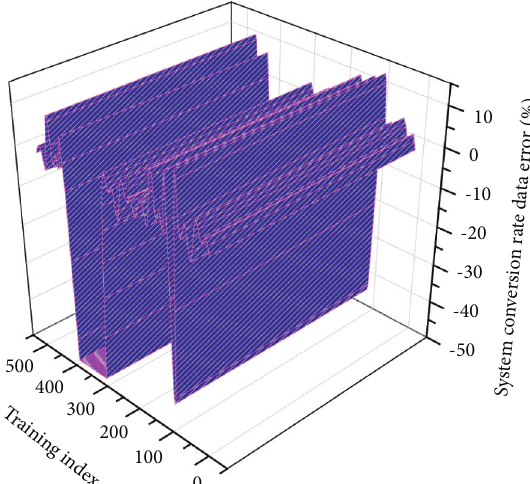
Figure 3: Three-dimensional data distribution of the system conversion